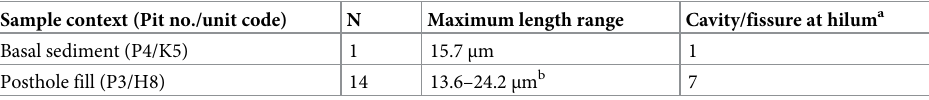
Table 1. Length and cavity attributes of starch granules > 13.2 μ m from I44/21 S pit contexts. Sample context (Pit no./unit code) N Maximum length range Cavity/fissure at hilum a Basal sediment (P4/K5) 1 15.7 μ m 1 Posthole fill (P3/H8) 14 13.6–24.2 μ m b